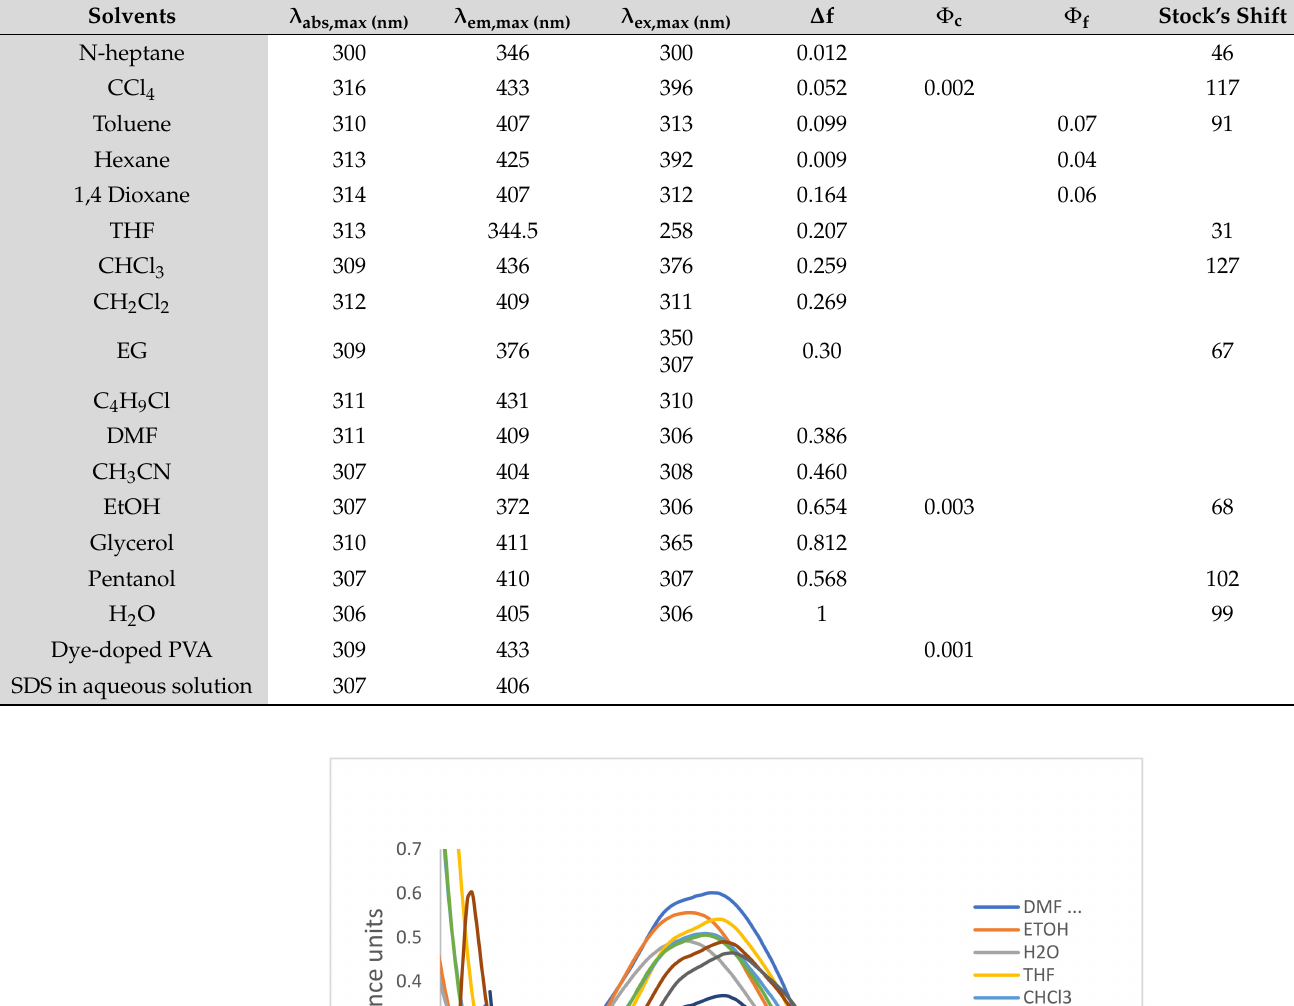
Table 7. Measured maximum absorption ( λ abs ) and emission wavelengths ( λ em ) for 2-amino-4-